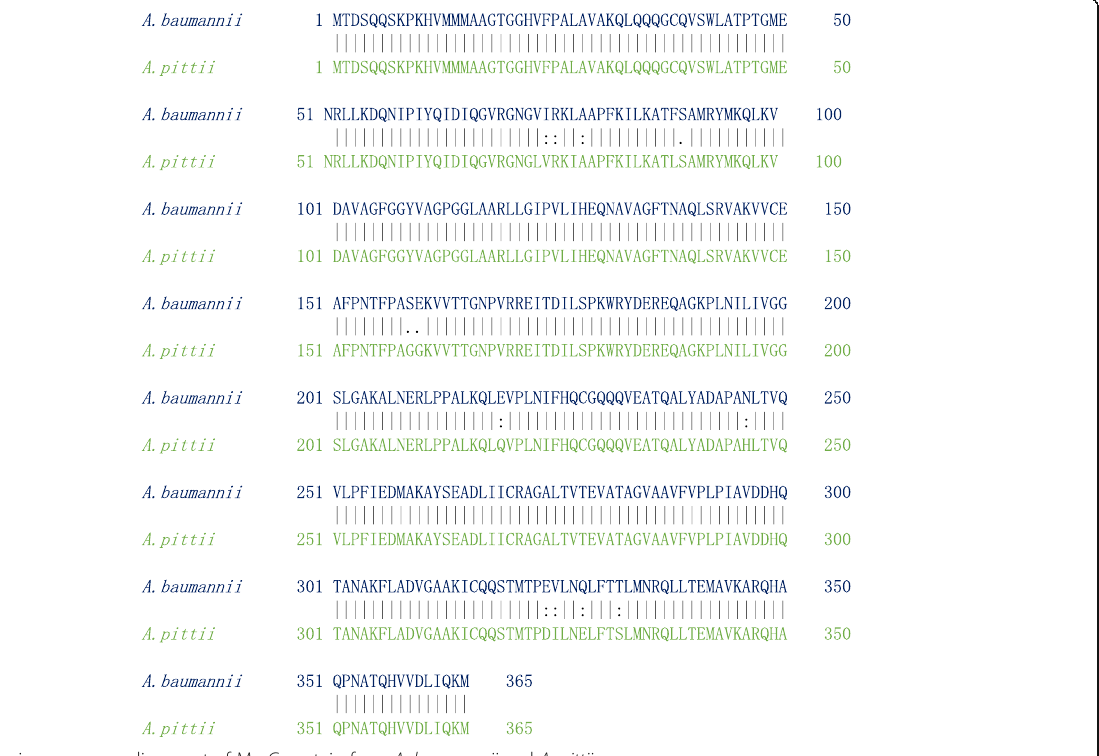
Fig. 13 Pairwise sequence alignment of MurG protein from A . baumannii and A .